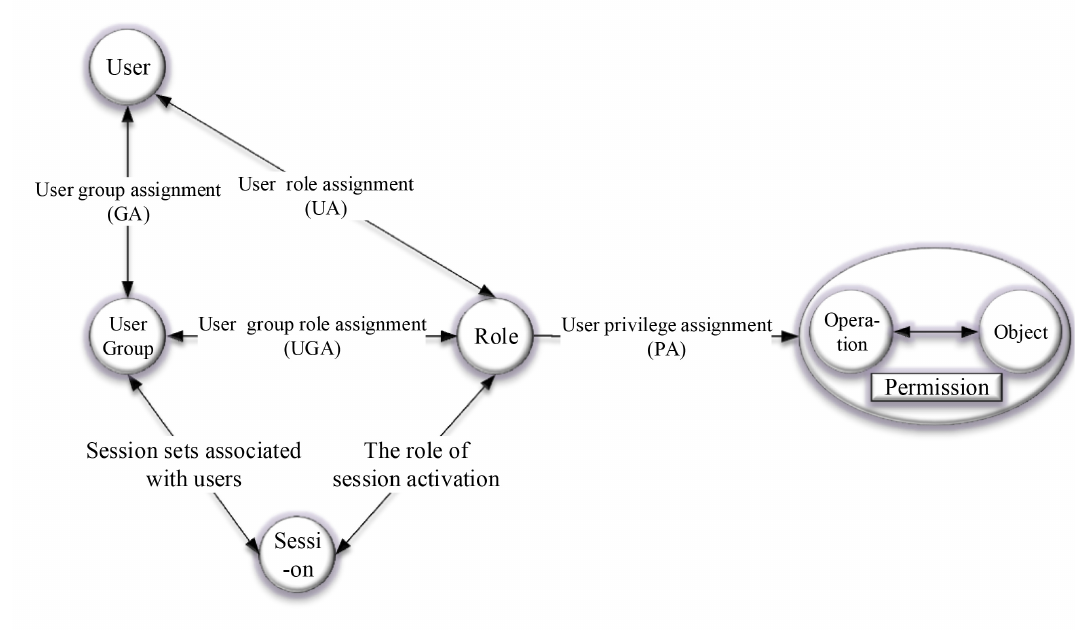
Figure 1. Context-aware Access Control with